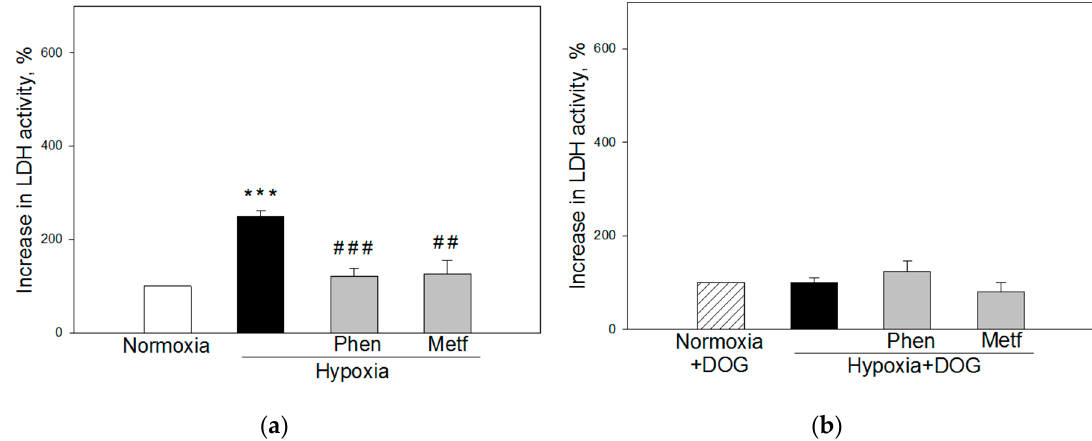
Figure 4. Effect of phenformin and metformin on hypoxia-induced ( a ) and simulated ischemia-induced ( b ) necrosis in brain slice cultures from 2–3 months old rats. Where indicated, 0.025 mM of phenformin (Phen) or 0.5 mM of metformin (Metf) was added to slice culture incubation medium before the start of hypoxia ( a ) or simulated ischemia ( b ) as described in Methods. The level of necrosis after hypoxia or simulated-ischemia was evaluated by measuring increase in LDH activity in slice culture medium. The data were normalized against normoxic controls of each group assuming that normoxic level is 100% and presented as means ± standard errors of 7–9 separate experiments. ***— p < 0.001 compared normoxic control without DOG, ##— p < 0.01; ###— p < 0.001 compared to hypoxia without DOG. Altogether, the data suggest that metformin and phenformin reduce hypoxia-induced necrotic cell death in brain slice cultures of adult rats, while in brain slices of premature animals only phenformin has the protective e ff